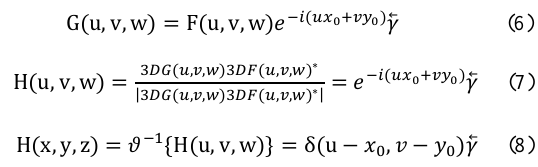
Figure 7. Matching process based on structure features and 3D phase correlation